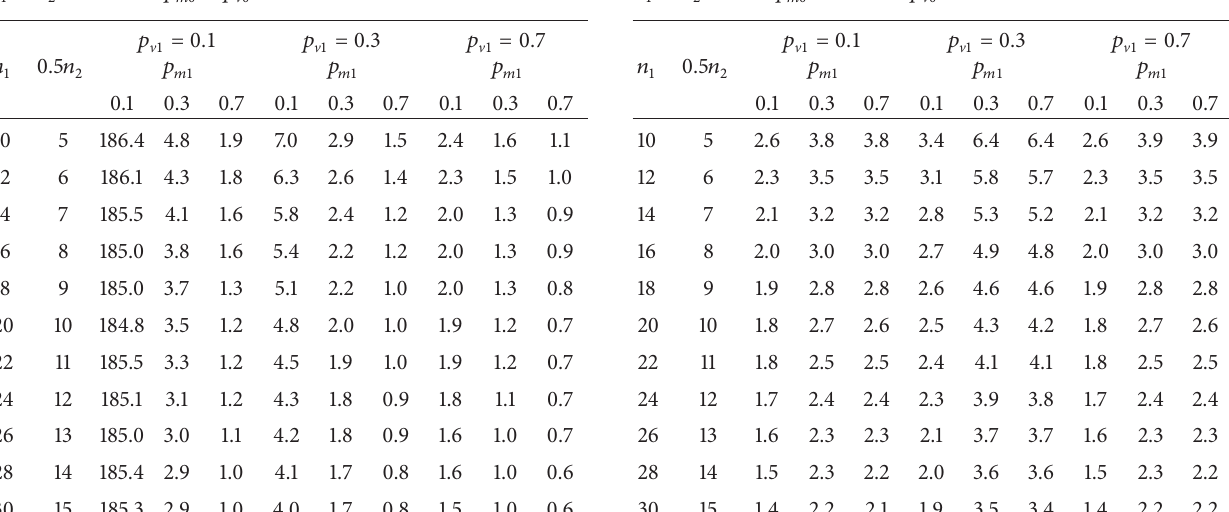
Table 9: The ARL 1 of the EWMA-AM and EWMA-AV charts for 𝜆